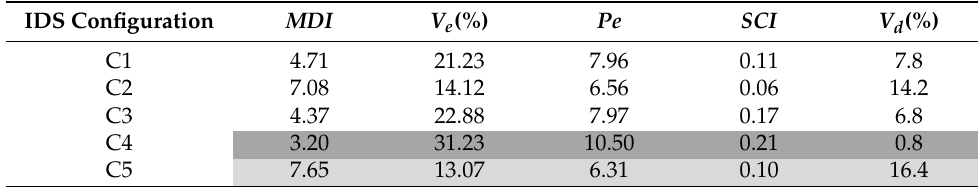
Table 5. Hydrodynamic characterization of UASB with different IDS